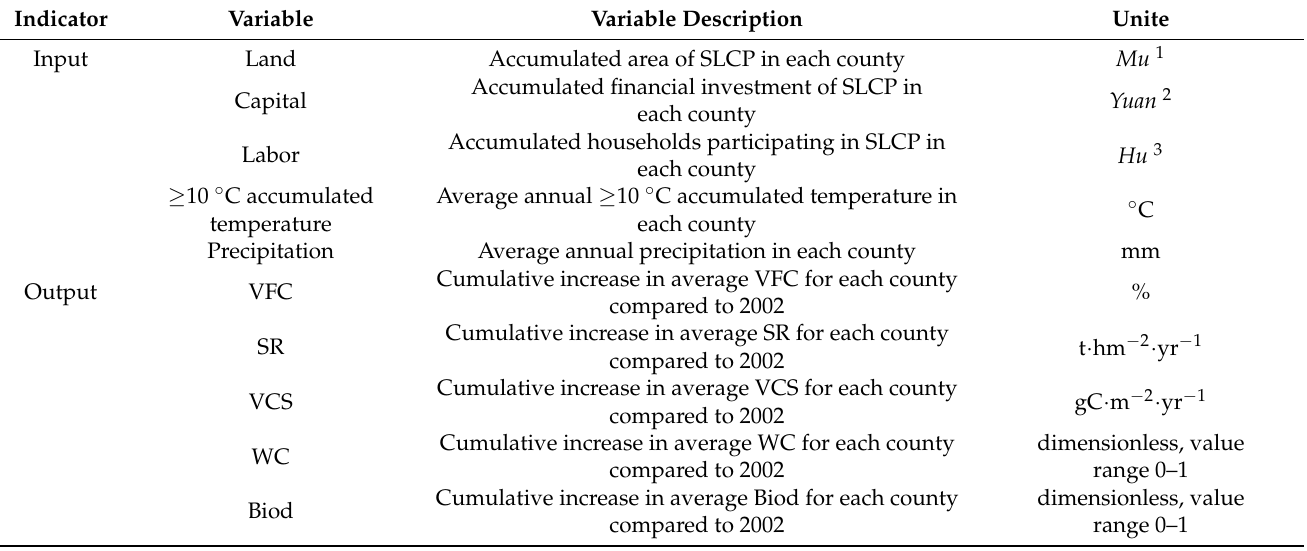
Table 1. EEoSLCP measurement index